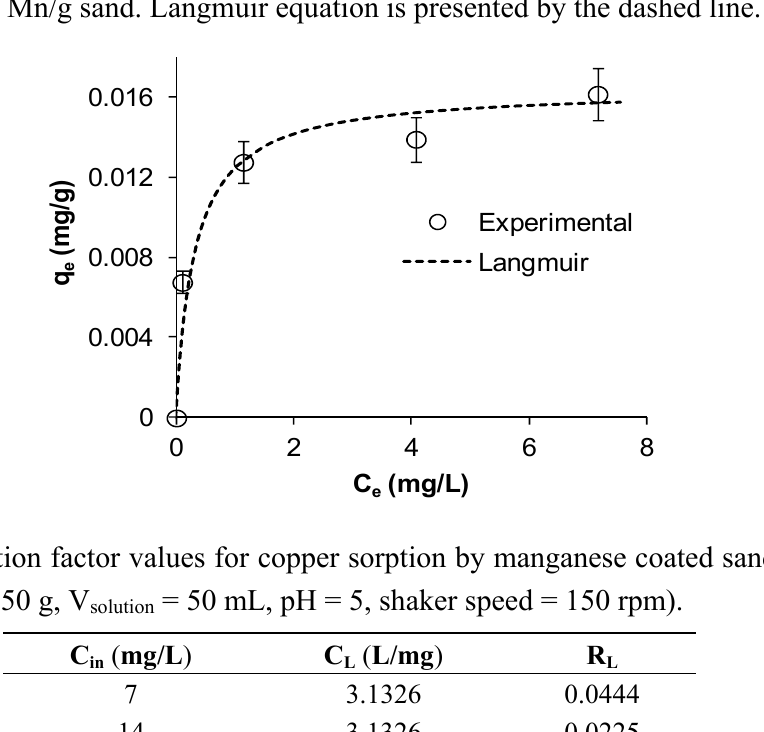
Figure 1. Equilibrium isotherm of Cu adsorption by MCS at 25.6 °C, pH = 5 and γ = 0.0709 mg Mn/g sand. Langmuir equation is presented by the dashed line. Mn